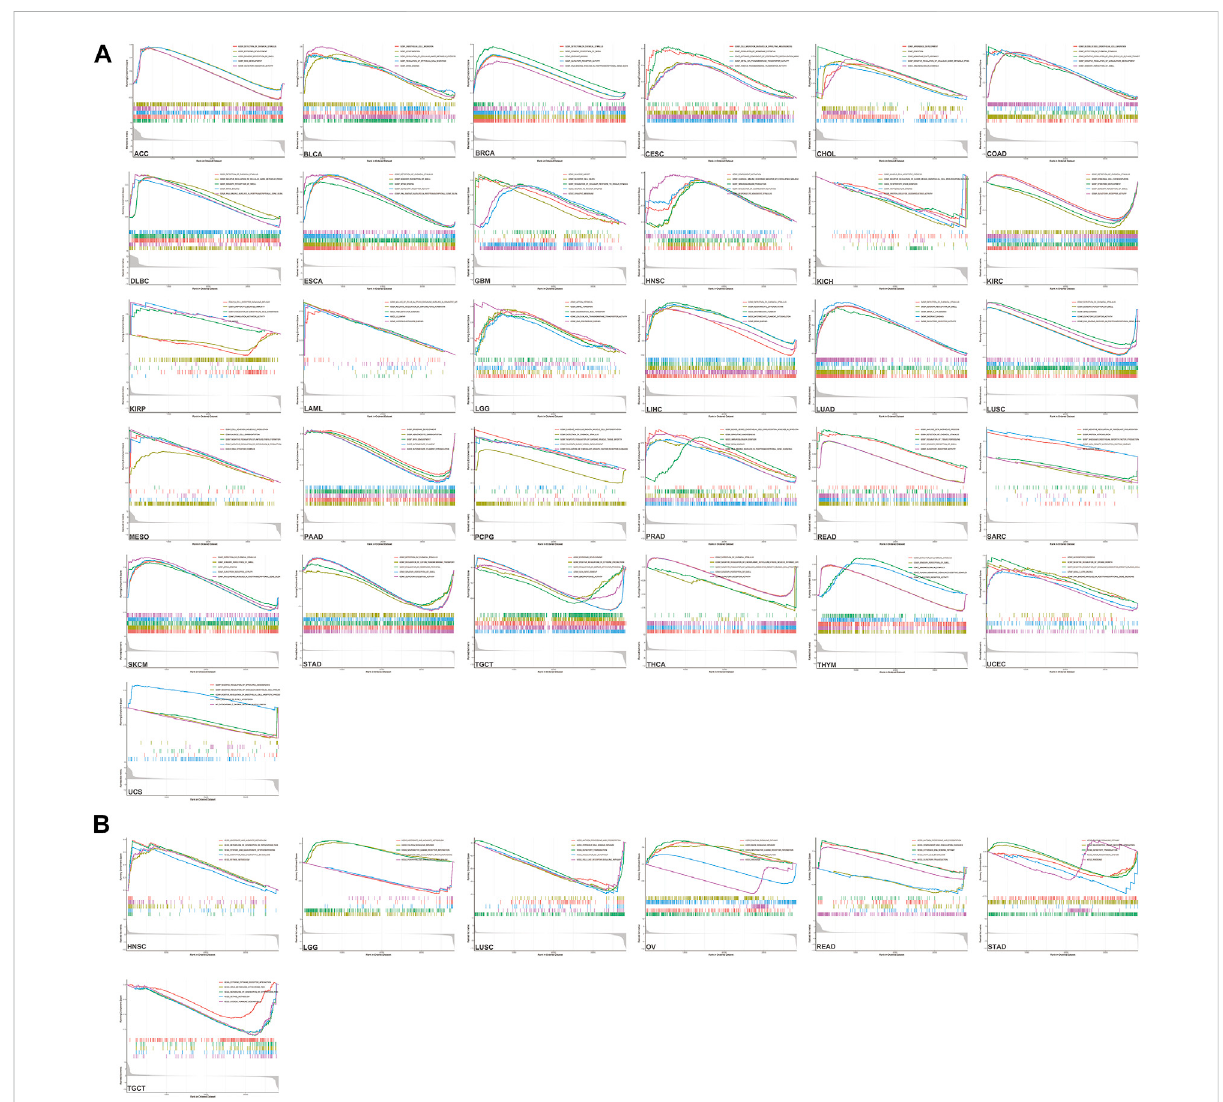
FIGURE 7 GSEA enrichment analysis of KRAS (A) Go enrichment analysis in various tumors. (B) KEGG enrichment analysis in various tumors.